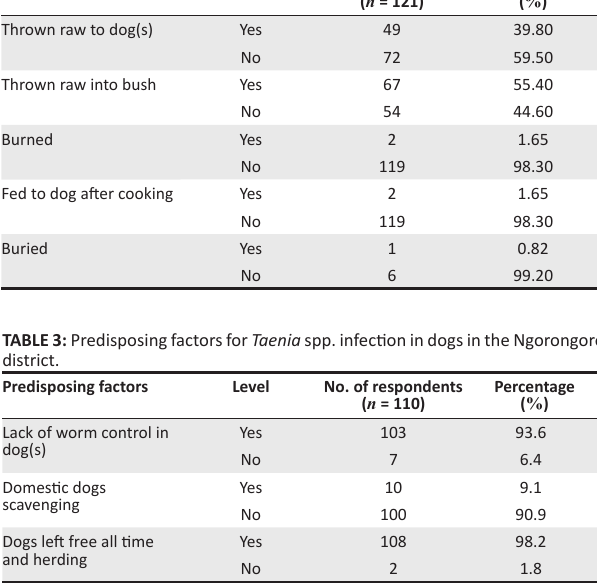
TABLE 2: Mode of disposal of condemned brains and other infected organs from slaughtered large and small ruminants. Parameter